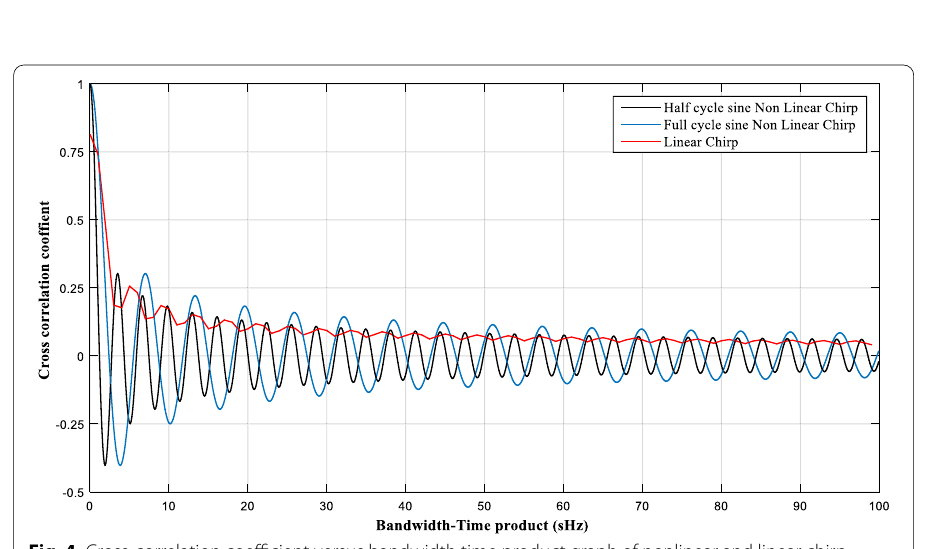
Fig. 4 Cross-correlation coefficient versus bandwidth time product graph of nonlinear and linear